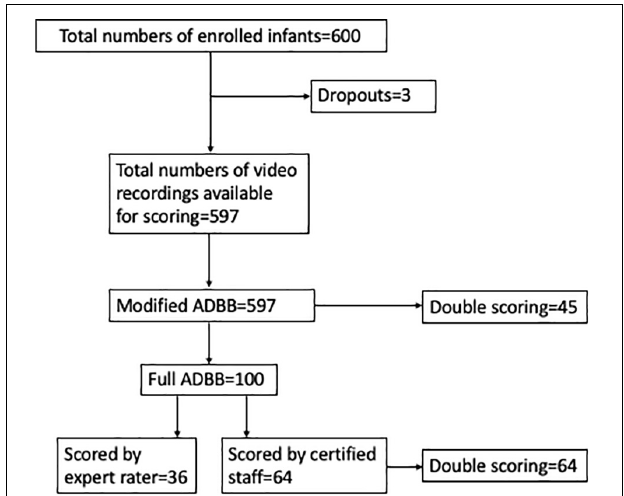
FIGURE 1 | Flowchart of the 600 enrolled Nepalese infants and the number of modified and full ADBB scorings in the